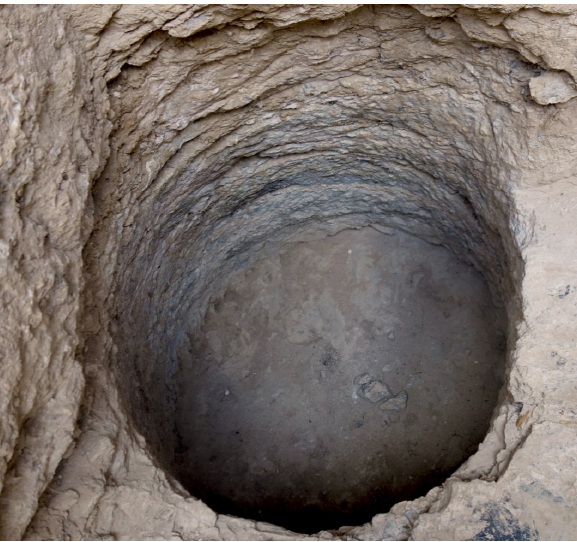
Figure 11. Collection pit of the burial